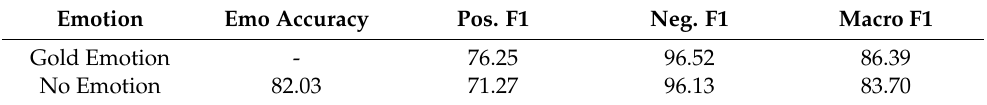
Table 4. Comparison results for the impact of emotion information on our proposed model.